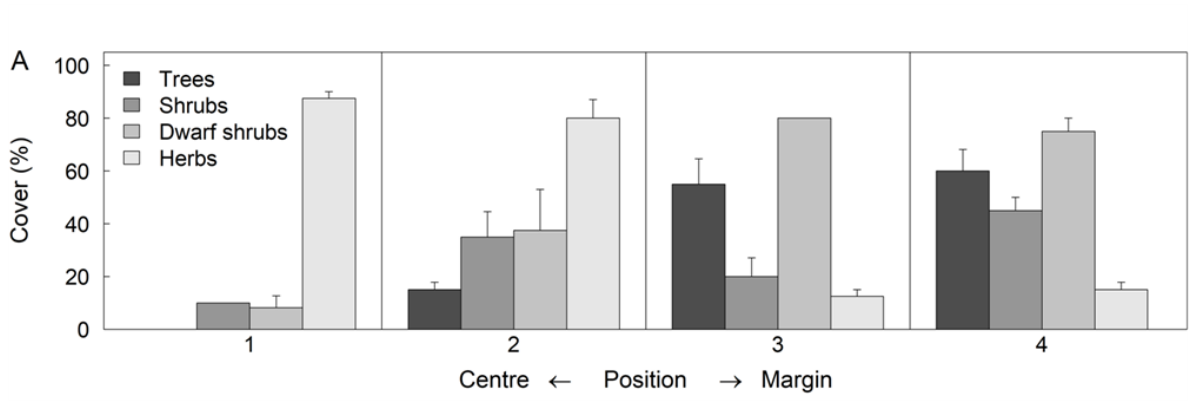
Figure A2. Percentage cover of tree, shrub, dwarf shrub and herb layer at Positions 1–4 along the two transects from the centre to the margin of the